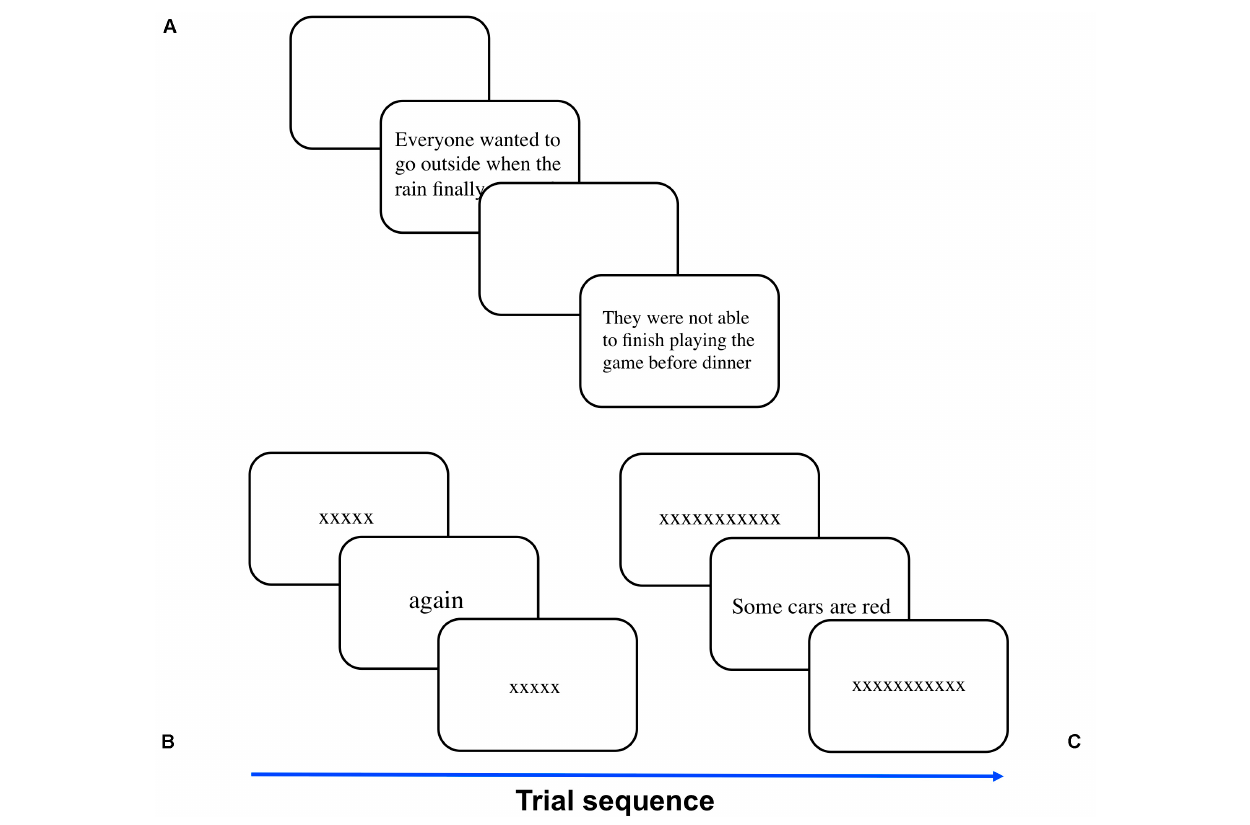
FIGURE 2 | Illustration of the three reading tasks. (A) Observers were timed while they read aloud sentences selected from the 38 items from MNREAD charts 1 and 2. The font size decreased each time the observer successfully read a sentence until the font was too small. In 2AFC tasks, observers reported whether (B) pentagrams were words or non-words or (C) 4-word sentences were logically true or false. Font size conditions were randomly interleaved and a staircase adjusted the presentation duration for each font size condition. The pentagrams or sentences were pre- and post-masked with a string of X’s of the same size and length as the test